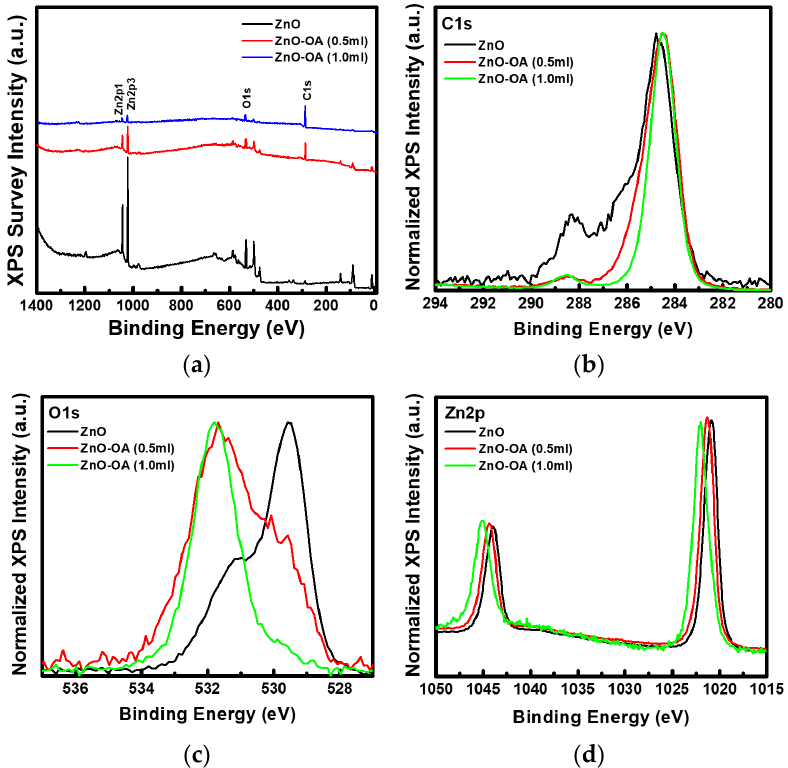
Figure 5. XPS ( a ) survey spectra, ( b ) C1s, ( c ) O1s, and ( d ) Zn2p core-level spectra of ZnO QDs and ZnO-OA (0.5 mL, 1.0 mL) QDs.